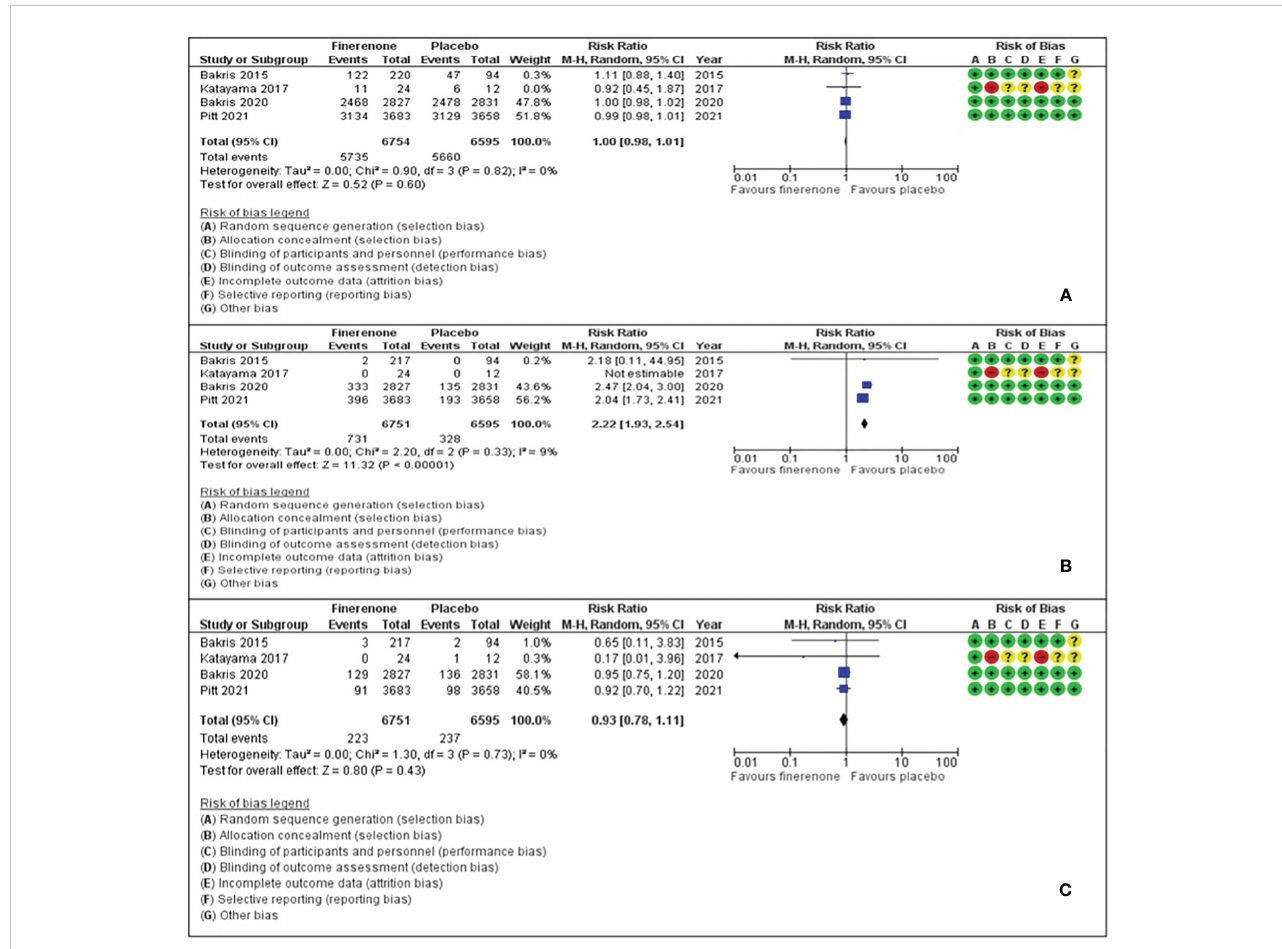
FIGURE 3 Effect of fi nerenone versus placebo on: (A) Any adverse events. (B) Hyperkalaemia. (C) Acute renal injury or eGFR decline of ≥